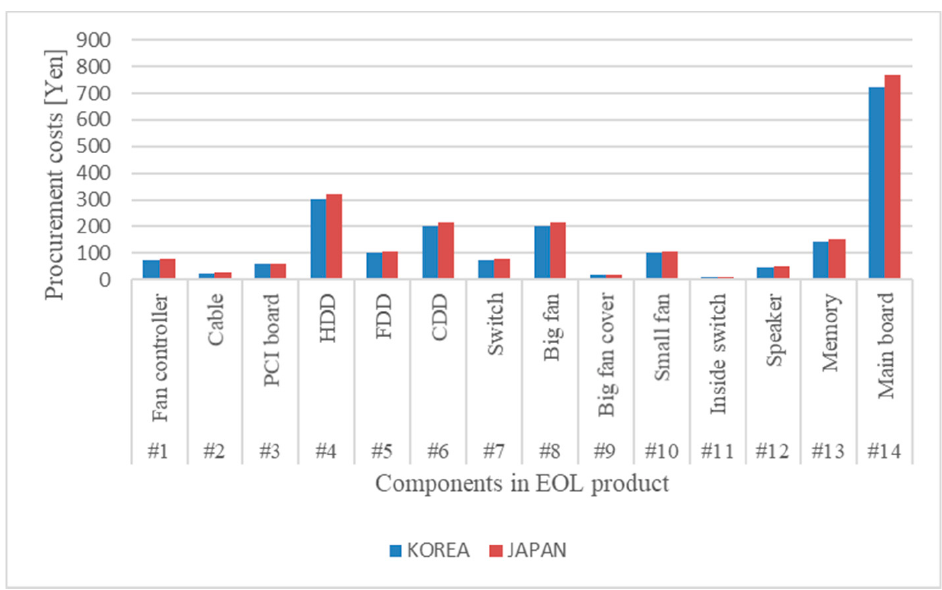
Figure 4. Comparison of procurement cost of each component in Korea and Japan.